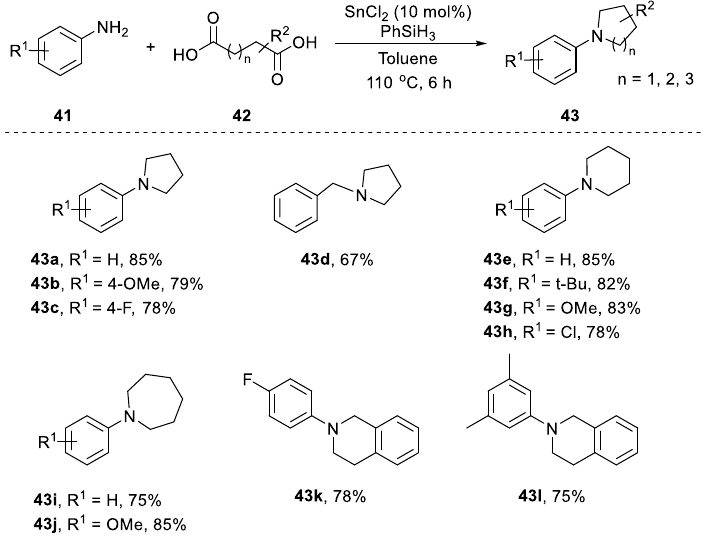
Scheme 10. Reductive amination of dicarboxylic acids and aryl amines using SnCl 2 and PhSiH 3 . The proposed pathway for this reaction is shown in Scheme 11. Initially, succinic acid